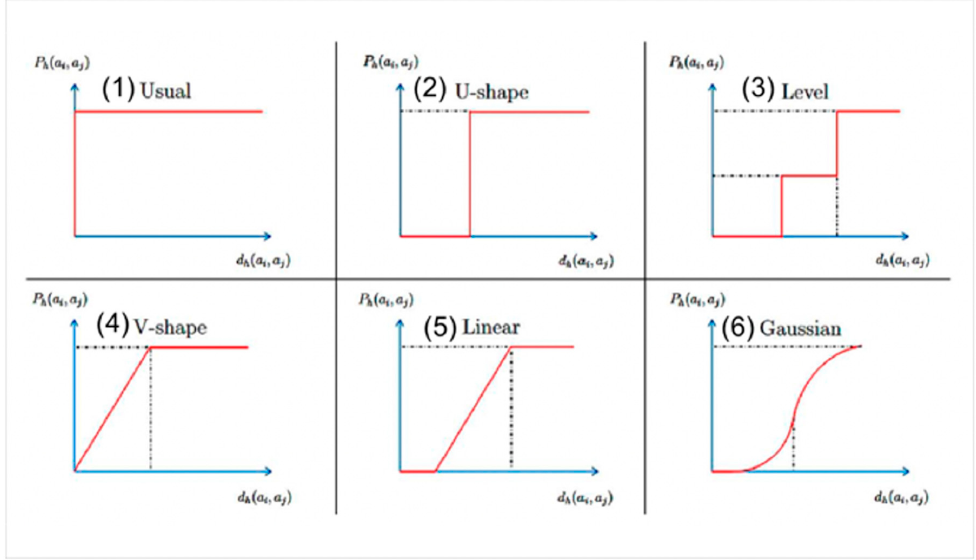
Figure 2. Various functions that can be used to maximize the criteria and sub-criteria [37].